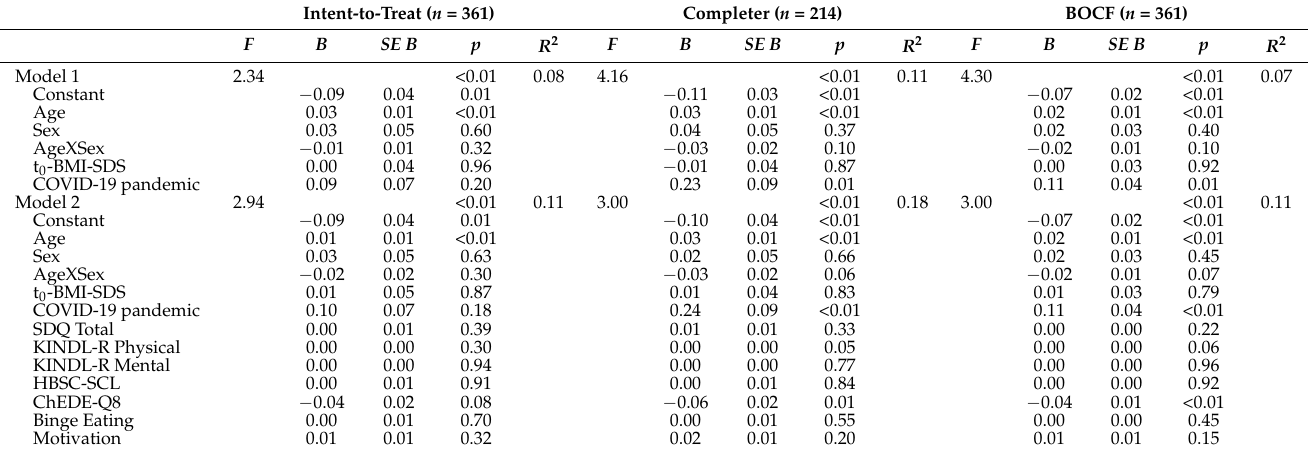
Table 2. Linear regression analysis for predictors of ∆ -BMI-SDS (unstandardized coefficients).